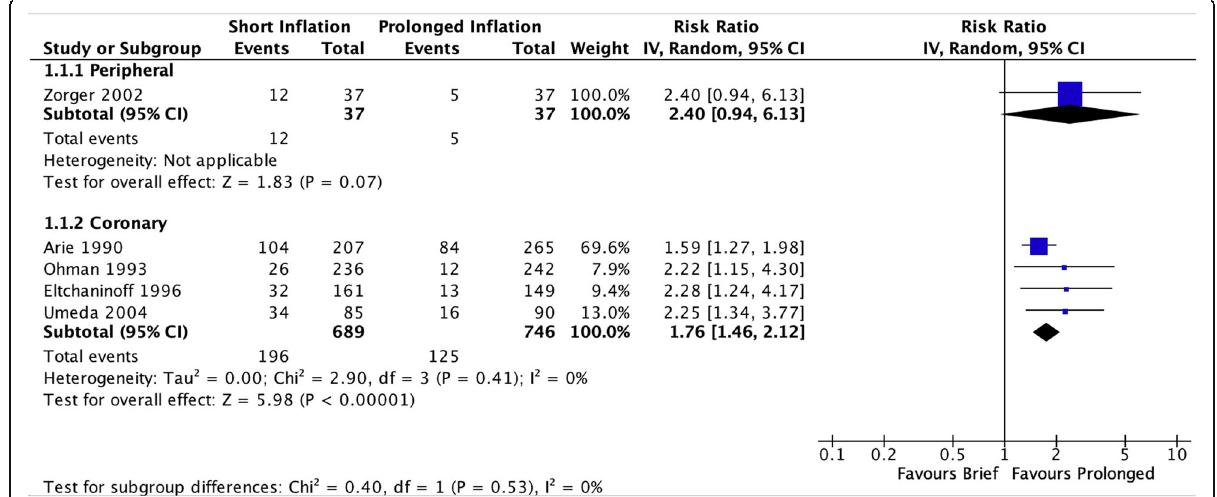
Fig. 2 Risk of residual stenosis immediately after initial angioplasty inflation